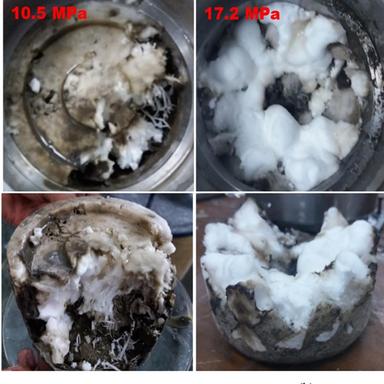
Hydrate formed in sediment at (a) 10.5 MPa and (b) 17.2 MPa.